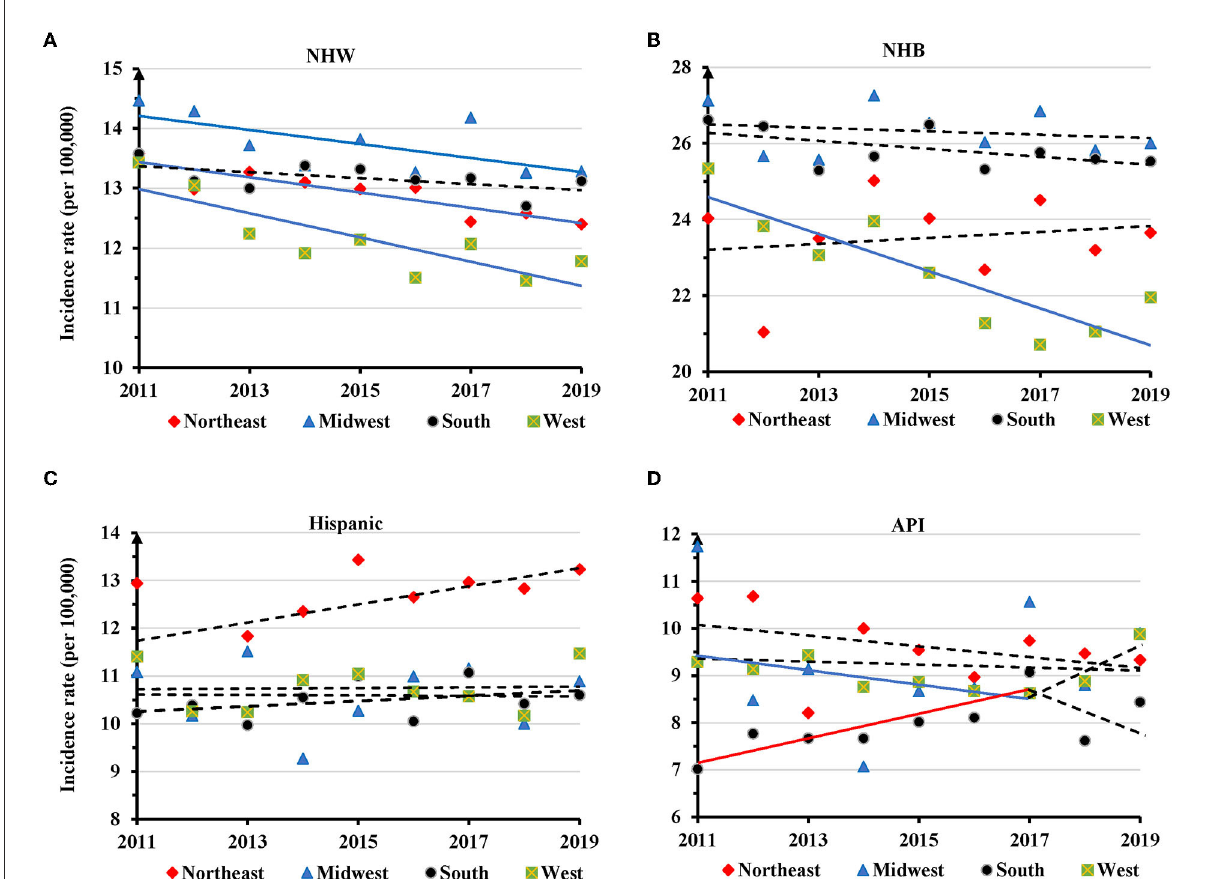
FIGURE5 Temporal changes in age adjusted incidence rates of TNBC by region in individual races during 2011–2019. (A) NHW. (B) NHB. (C) Hispanic. (D) API. Solid trend lines indicate a significant annual percentage change (APC) of age adjusted incidence rate. Dashed lines show no significant